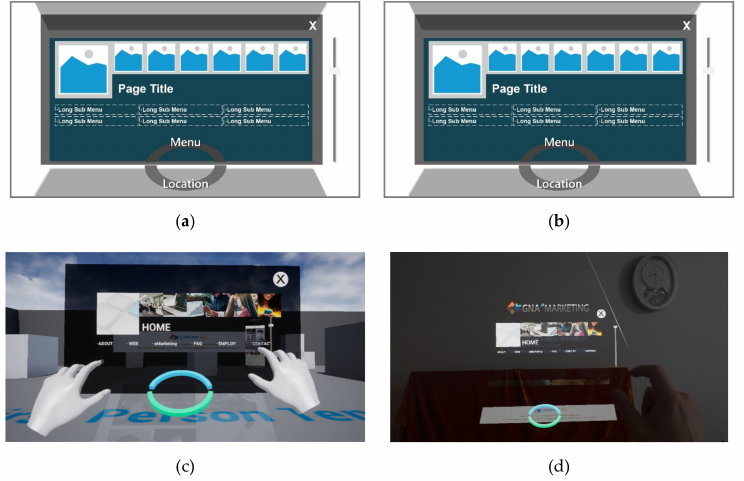
Figure 13. Menu panel details: ( a ) Menu panel concept; ( b ) Concept for overall page description [21]; ( c ) Menu prototype panel (VR); ( d ) Menu panel prototype